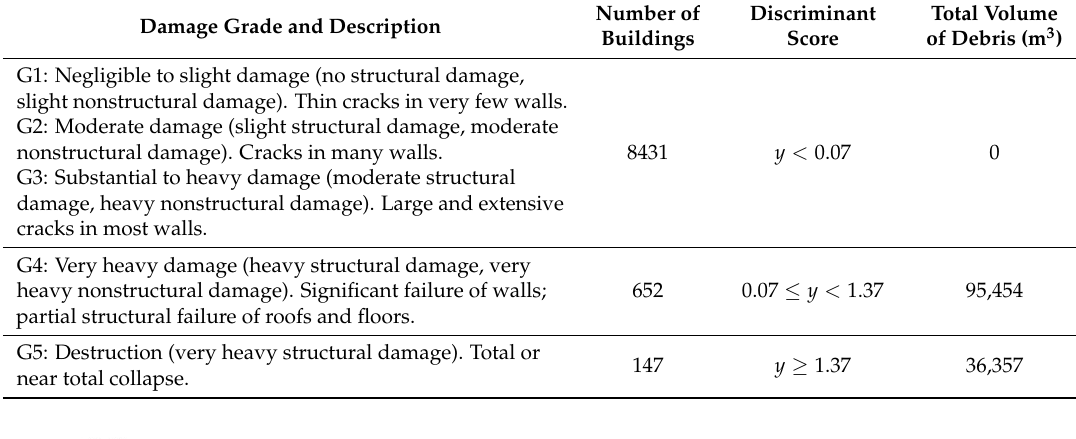
Number of Discriminant Total Volume Buildings Score of Debris (m 3 )